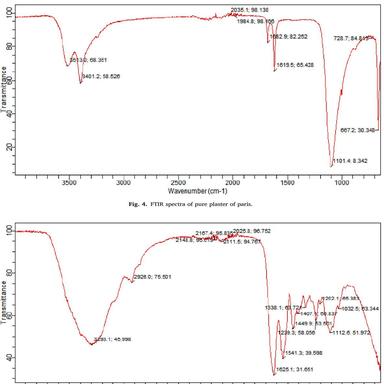
FTIR spectra of leather waste.